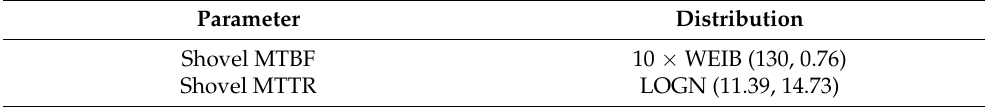
Table A2 represent mean-time-between-failure (MTBF) and mean-time-to-repair (MTTR) for shovels. Table A2. BRO input